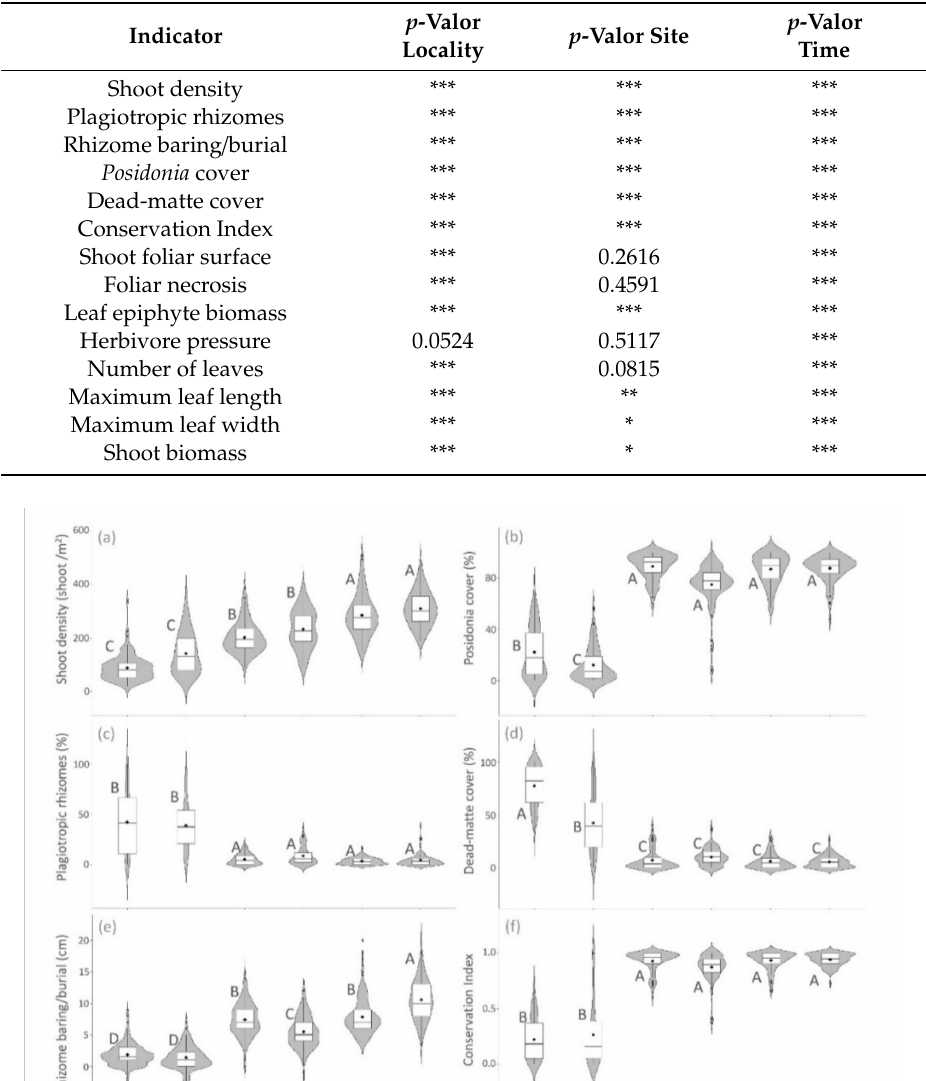
Table 1. Summary of the results from the ANOVA applied to di ff erent Posidonia indicators for the six locations (* p -value < 0.05; ** p -value < 0.01; *** p -value < 0.001; when p -valor is not significant, its real value is shown).